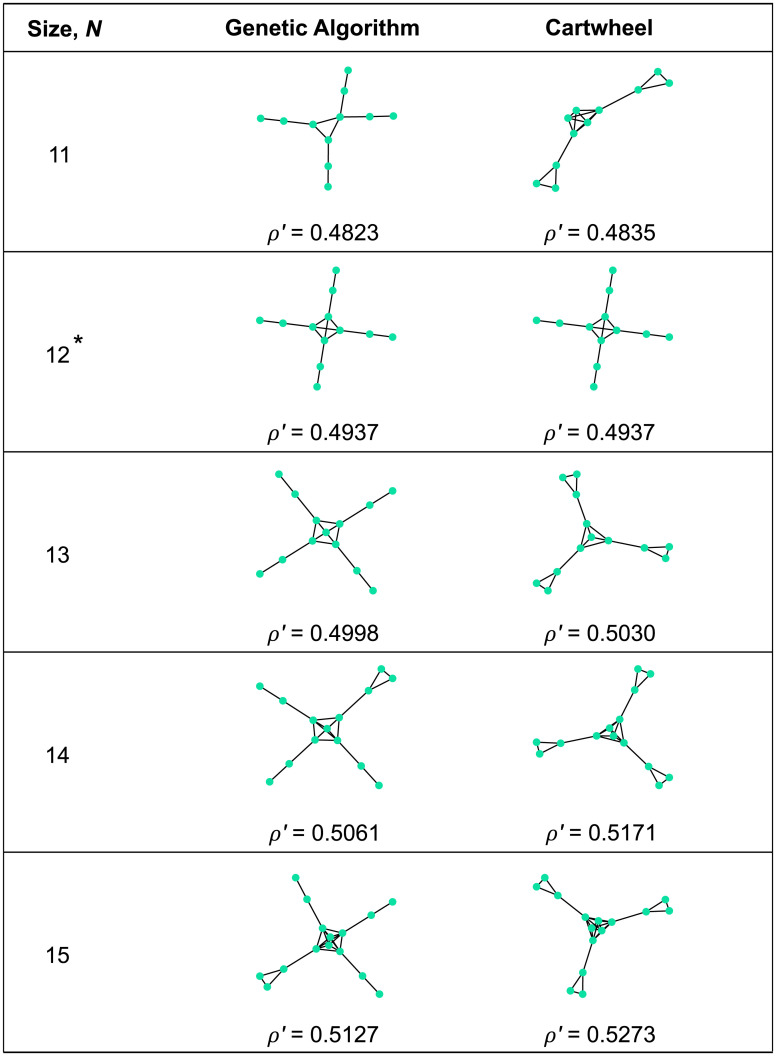
Discovering absolute amplifiers for temperature initialization.We used a genetic algorithm to discover graphs with large weak-selection effect ρ′. The resulting graphs (middle column) have a central “hub” joined by single links to outlying “islands”. To formalize this structure, we introduce a family of “Cartwheel” graphs CWn,m,h, consisting of a hub of size h and n islands of m vertices each (rightmost column). We find that the optimal Cartwheel graph has ρ′ exceeding that found by the genetic algorithm, except for N = 12 for which the same graph was identified by both methods. All graphs found by both methods are absolute amplifiers of weak selection, meaning ρ′ > (N − 1)/(2N).